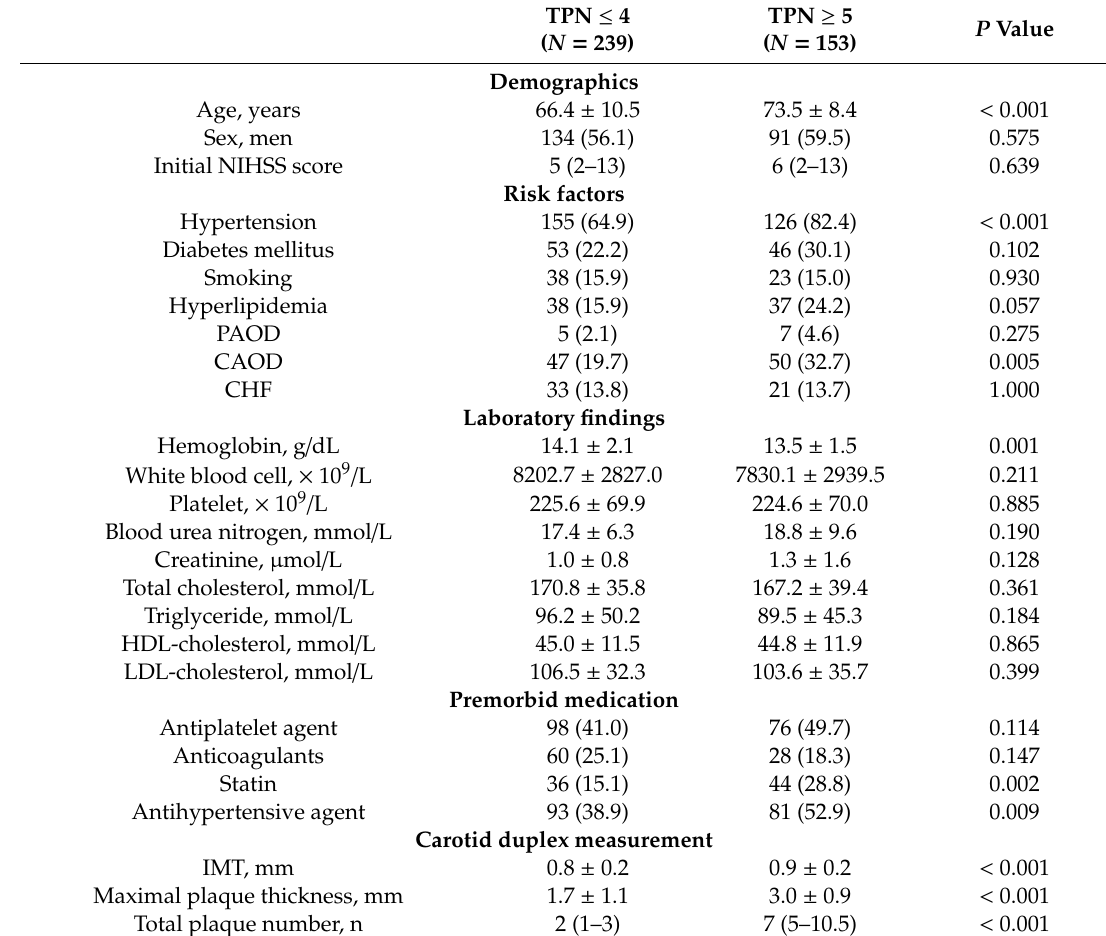
Table 1. Clinical characteristics of study patients according to the total carotid plaque number (TPN).